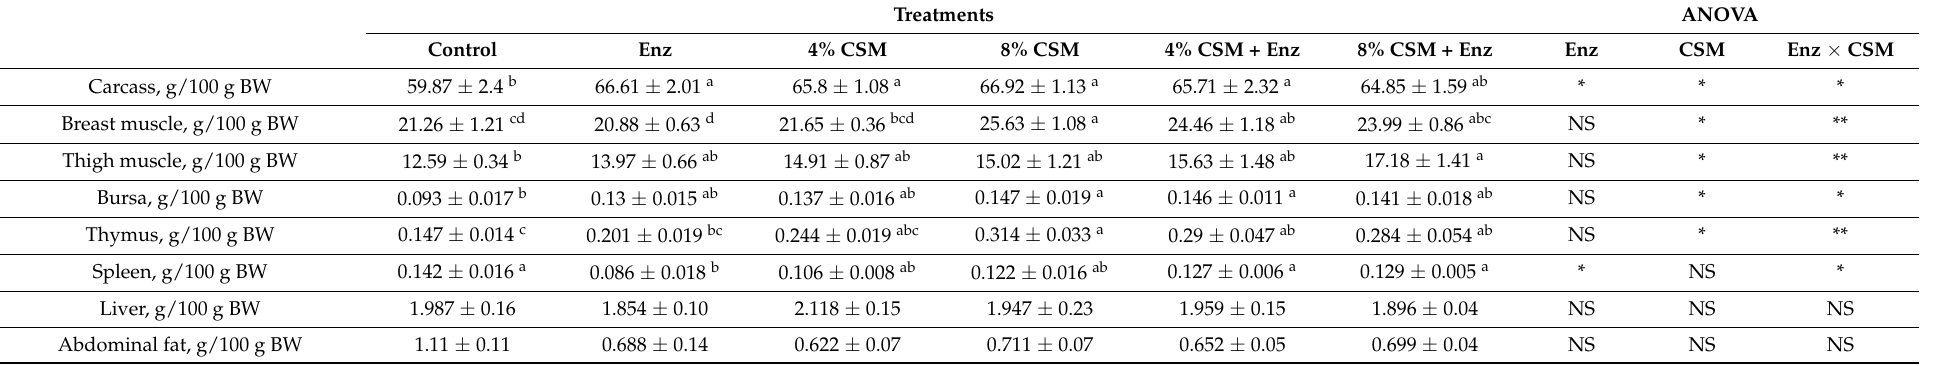
Table 5. Effects of feeding corn silk meal and/or NSP enzyme on carcass, organs weights and abdominal fat weights.